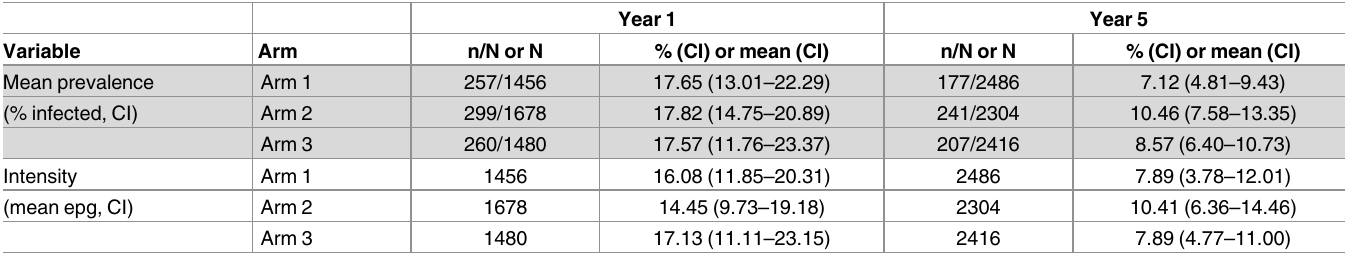
Table 1. Prevalence and intensity of infection in 9–12 year olds in each arm at baseline (Year 1) and final evaluation (Year 5).